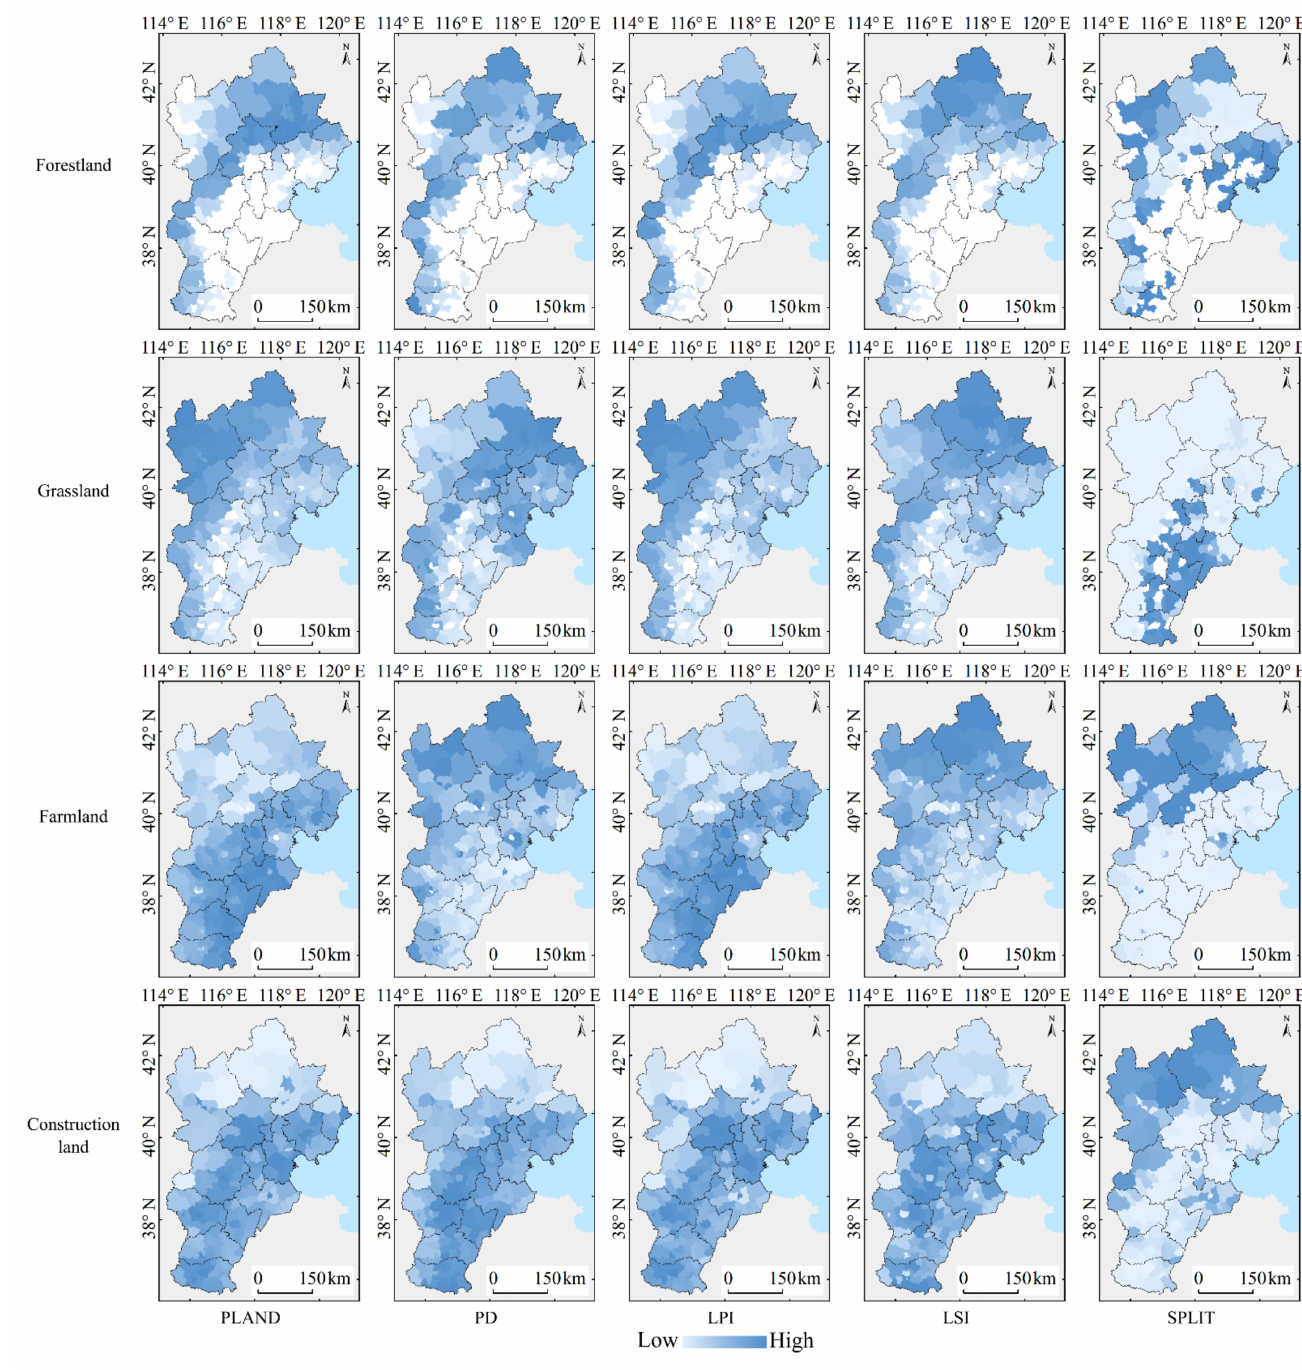
Figure 10. Spatial distributions of the landscape pattern indices at the class